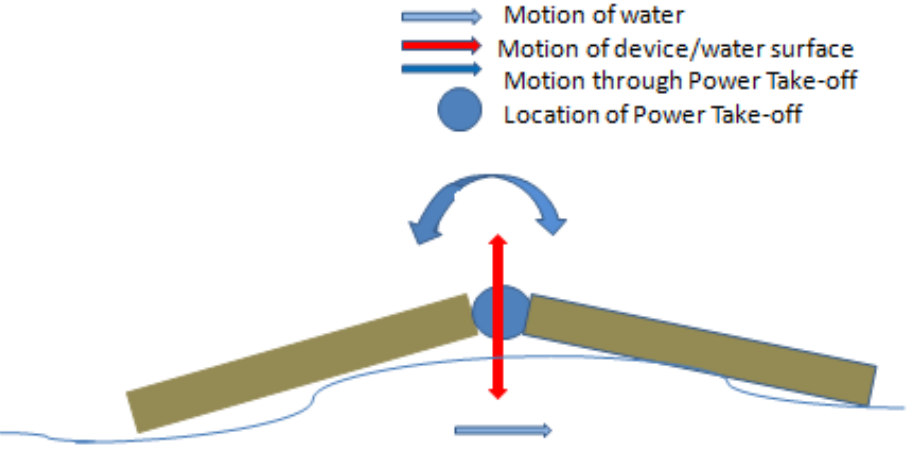
Figure 10. The concept of a wave-activated body.